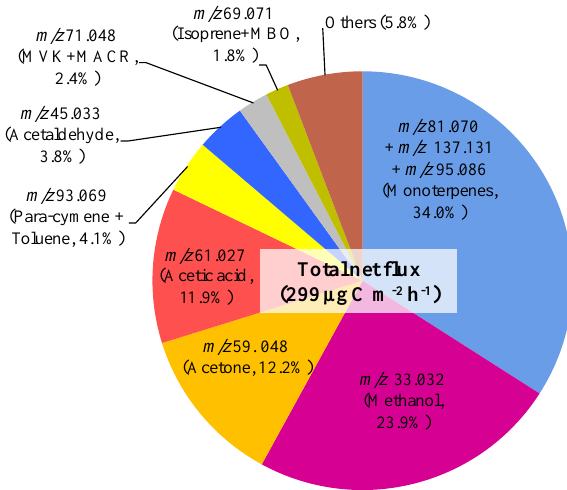
Fig. 13. Fractional contribution to the total flux for 27 ion species selected. 900